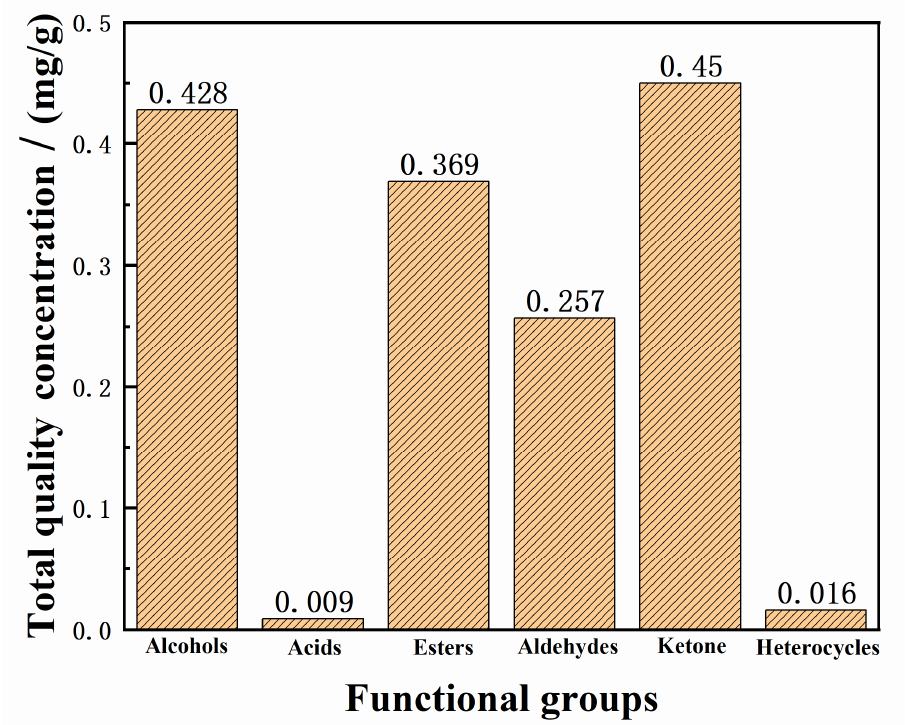
Figure 6. Total quality concentrations of the functional groups in ice cream samples.